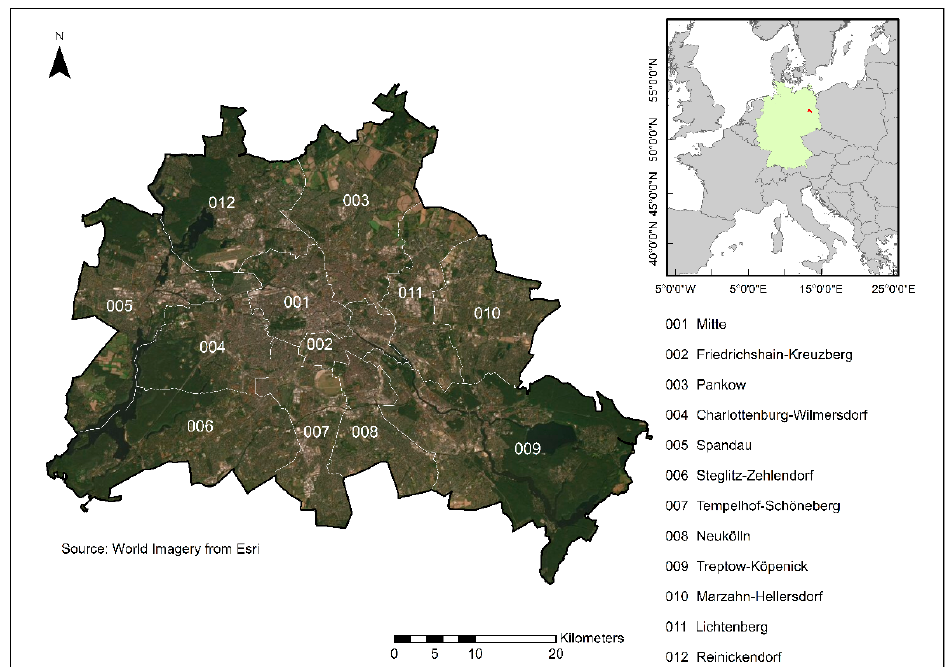
Figure 1. Study area map.